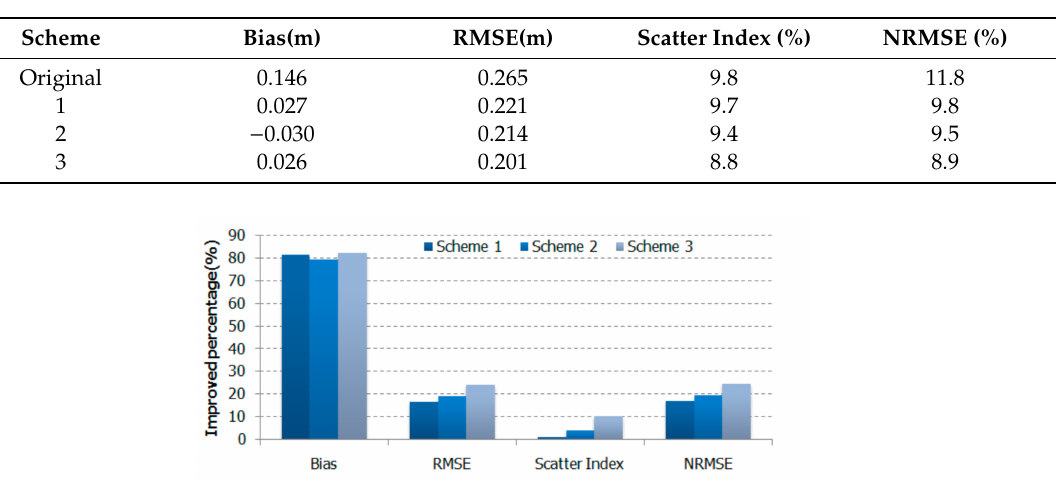
Table 2. Validation of SWH calibration DNN schemes (Sample# 199).